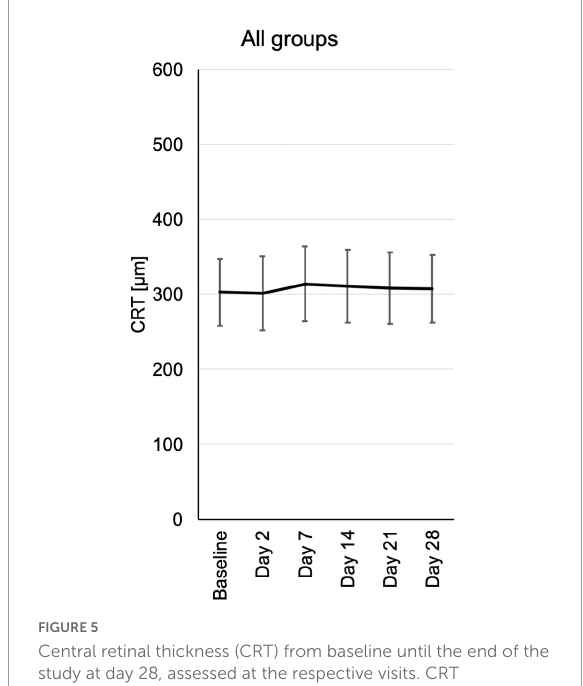
FIGURE5 Central retinal thickness (CRT) from baseline until the end of the study at day 28, assessed at the respective visits. CRT measurements were extracted from automated standard OCT (optical coherence tomography) of the central fovea of the macula. CRT is depicted for each visit of all patients pooled from the three different dosing groups.